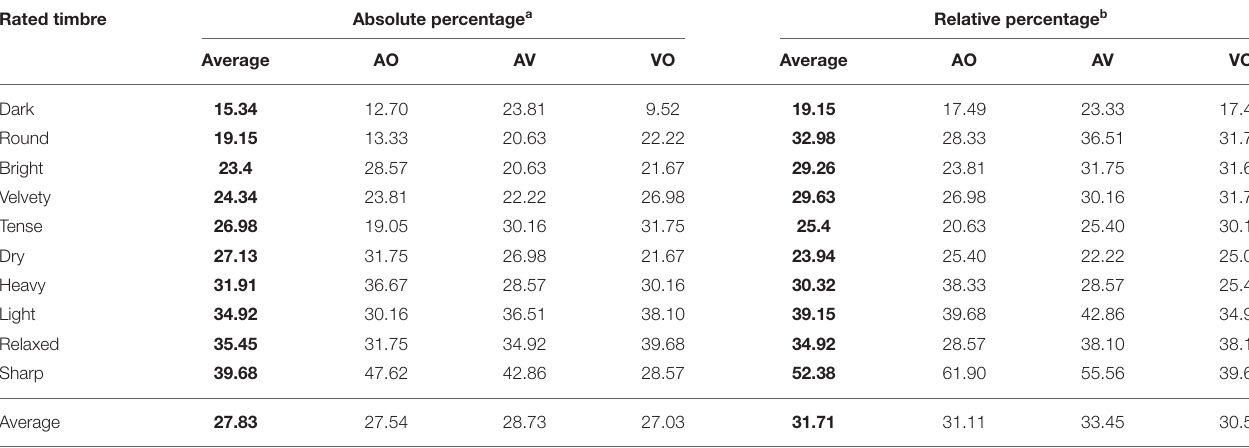
TABLE 2 | Percentage of listeners’ correct answers for a target timbre (values in each AV condition and their average). Rated timbre